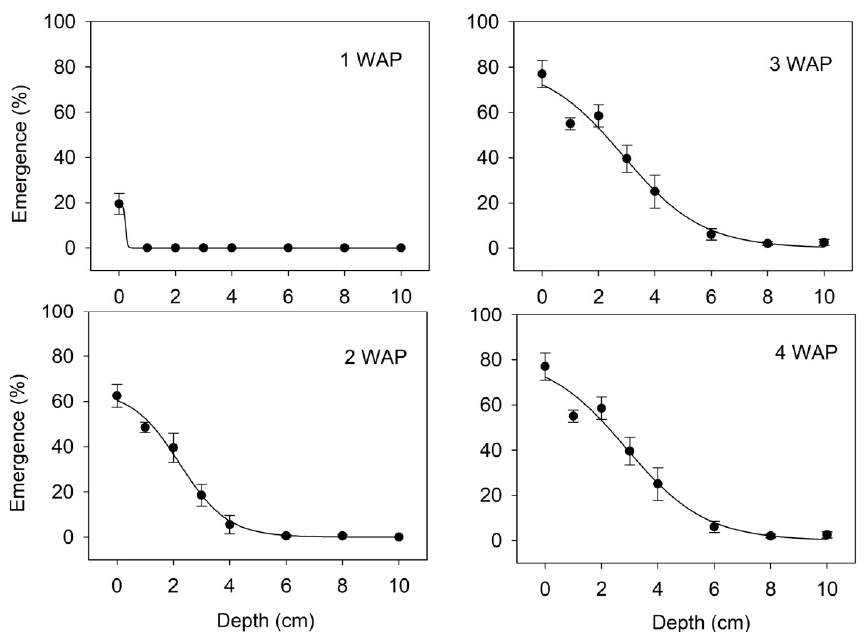
Figure 1. White clover seed germination over time at various burial depths. Data were regressed with the following equation: G = G max /{1 + exp[ − (x − x 0 )/ b ]}. Equation for 1 WAP was not available, p > 0.05 did not achieve a significant nonlinear relationship. Equation for 2 WAP was G = 64.89/{1 + exp[ − (x − 2.22)/ − 0.85]}, standard errors for G max , x 0 , b measured 6.51, 0.26, and 0.19, respectively, R 2 = 0.84, and p < 0.0001. Equation for 3 WAP was G = 78.84/{1 + exp[ − (x − 2.86)/ − 1.33]}, standard errors for G max , x 0 , b measured 10.62, 0.49, and 0.34, respectively, R 2 = 0.80, and p < 0.0001. Equation for 4 WAP was G = 81.12/{1 + exp[ − (x − 2.85)/ − 1.35]}, standard errors for G max , x 0 , b measured 10.76, 0.49, and 0.34, respectively, R 2 = 0.81, and p < 0.0001. Results were pooled over two experimental runs. Vertical bars represent standard errors ( n = 8). Abbreviation: WAP = weeks after planting.